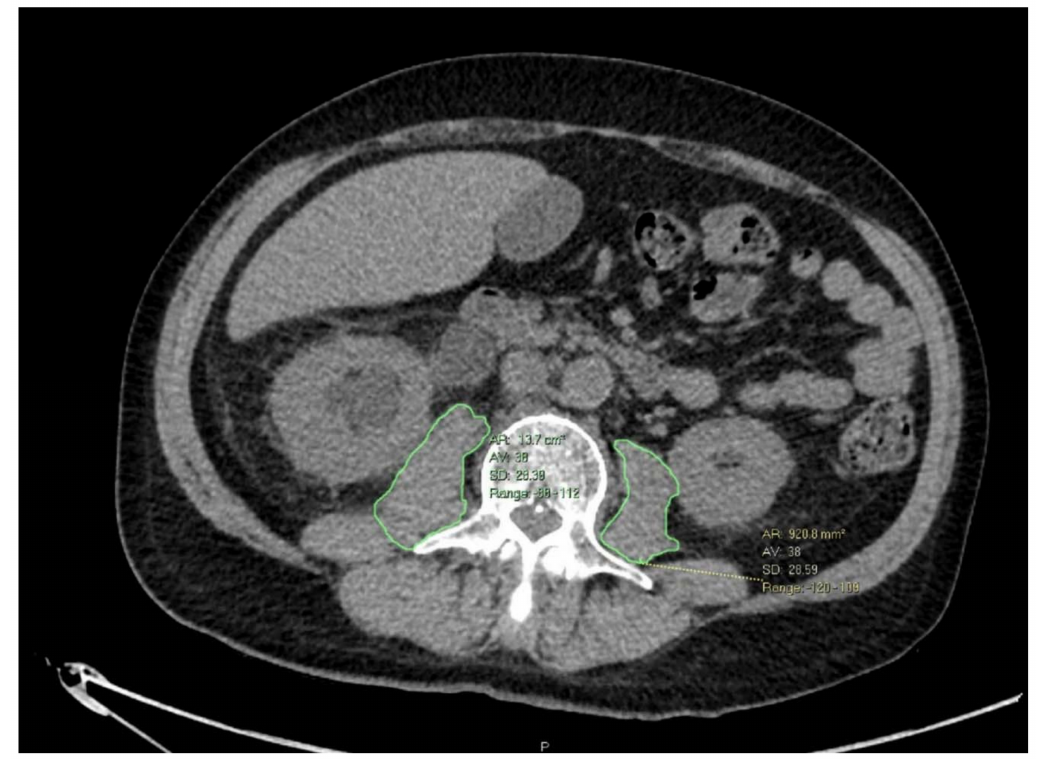
Figure 1. PMA measurements at the L3